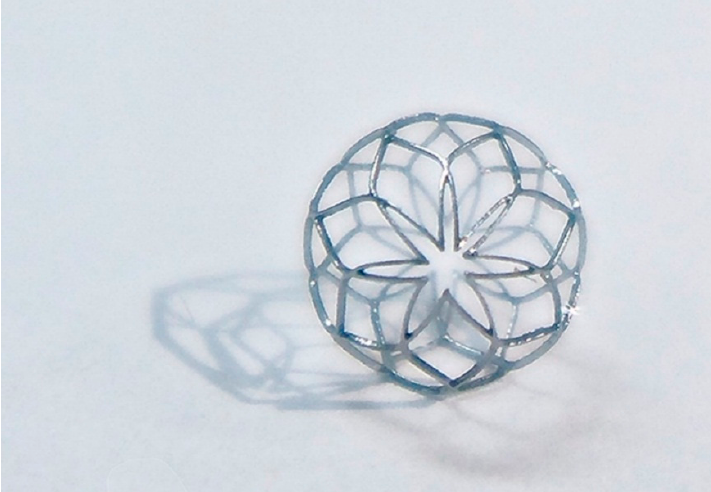
Figure 9. World’s first spherical occlusion device.